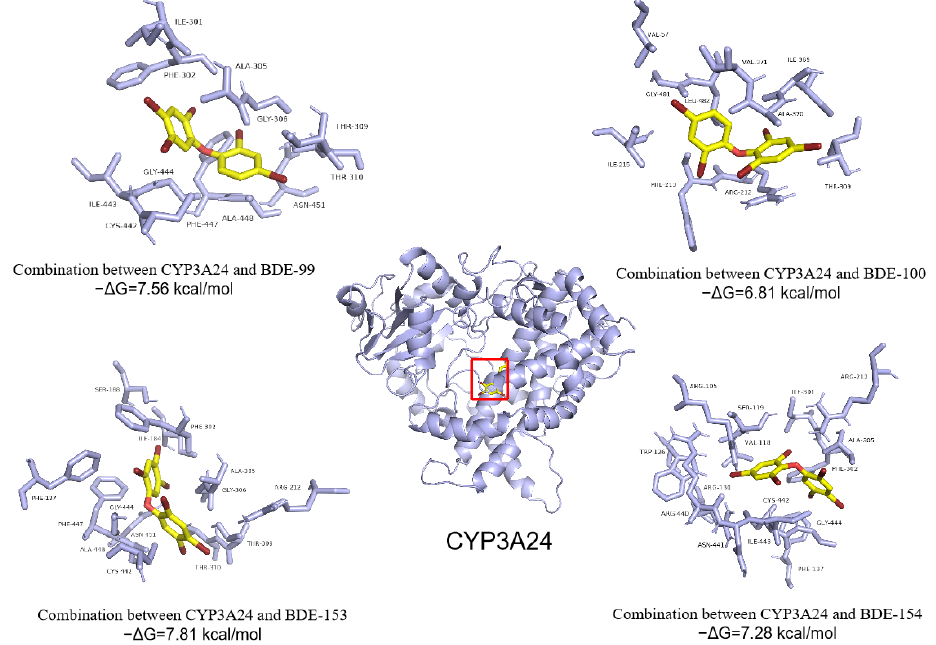
Figure 7. Molecular docking images for interactions between PBDE congeners and the Cytochrome P450 enzyme (CYP3A24) at 298.15 K and the amino acid residues in CYP3A24 that interact with the PBDE congeners over the range 4 Å.